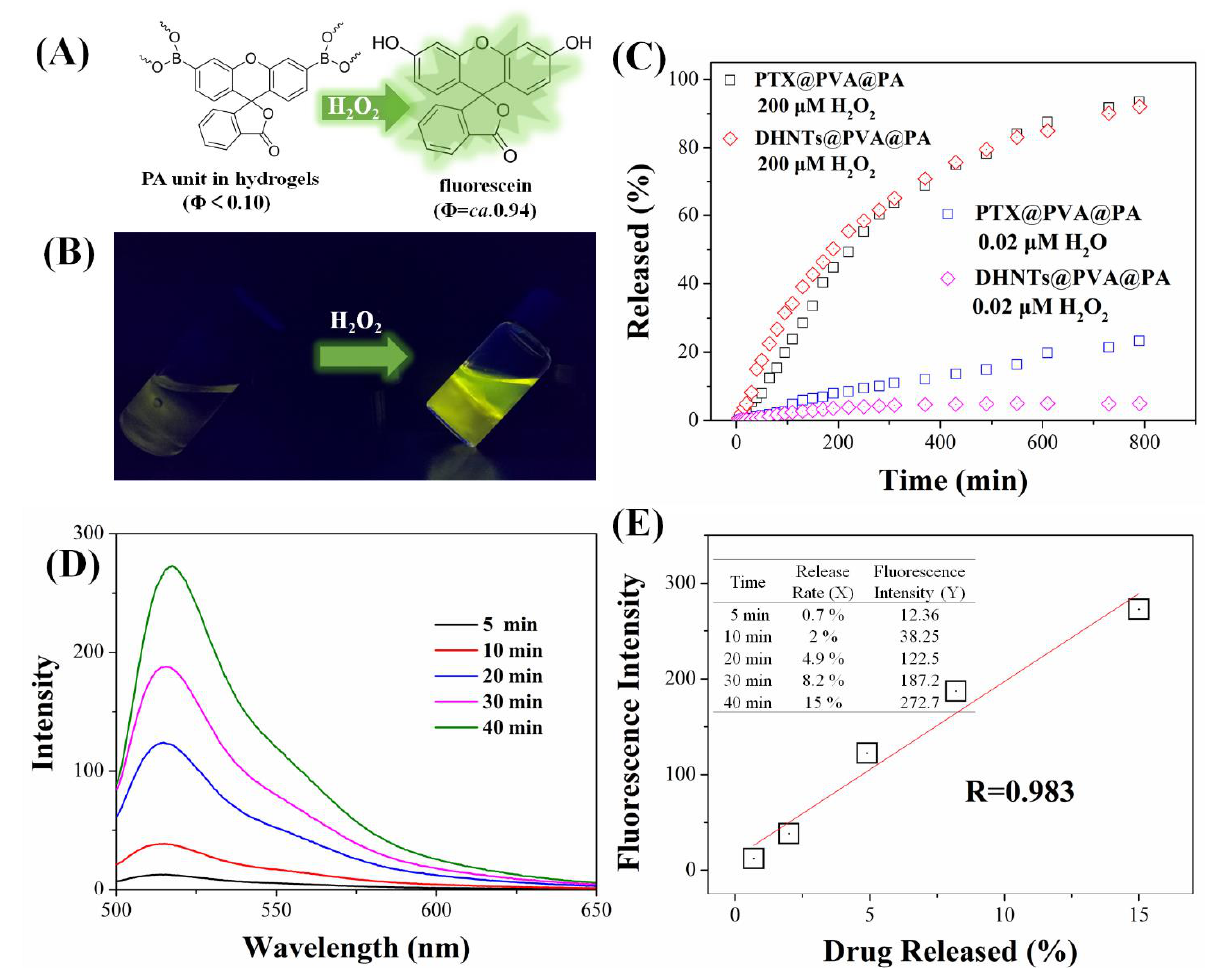
Figure 3. H 2 O 2 -responsive behaviors of the fluorescein-crosslinked hydrogels reported by our group: ( A ) The transformation mechanism of fluorescein-crosslinked hydrogels from arylboronates to phenols to afford fluorescein with high fluorescence in the presence of H 2 O 2 ; ( B ) the changes of the hydrogel from non-fluorescent to fluorescent; ( C ) the drug release profiles in different concentration of H 2 O 2 ; ( D ) the fluorescence spectra of the release medium (H 2 O 2 = 200 µ M) after addition of DHNTs@PVA@PA; ( E ) plots of fluorescence intensity vs. the drug release rate (Reprinted/adapted with permission from Ref. [51]. Copyright year: 2022, copyright owner’s name: Hailei Zhang)